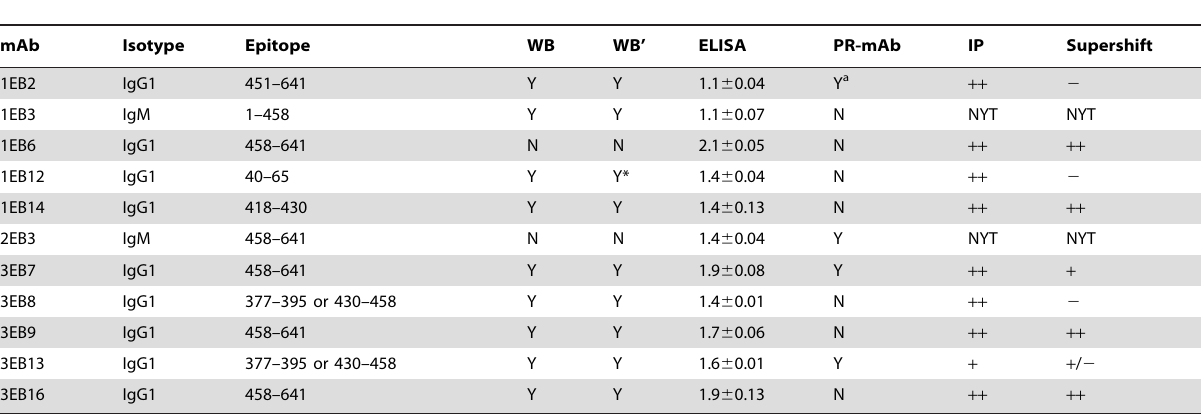
Table 1. Summary of anti-EBNA1 murine